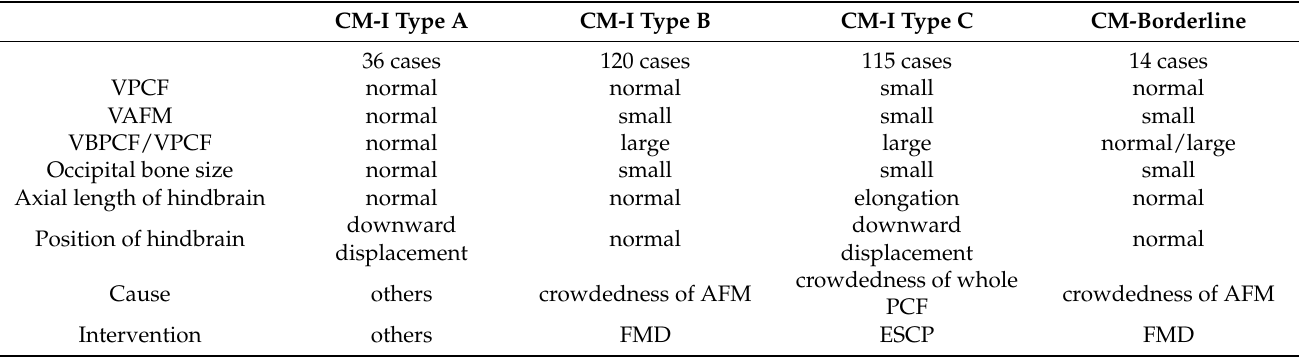
Table 1. Subtypes of Chiari malformation type I (CM-I) classified on the basis of morphometric analyses, cause of hindbrain ptosis, and surgical intervention. CM-I Type A